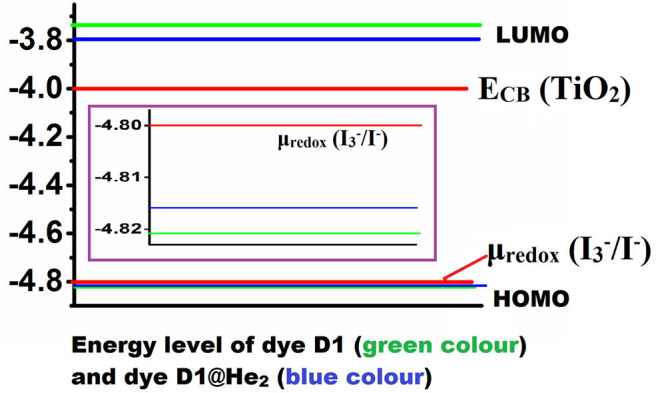
Energy level diagram of dyes D1 and D1@He2.